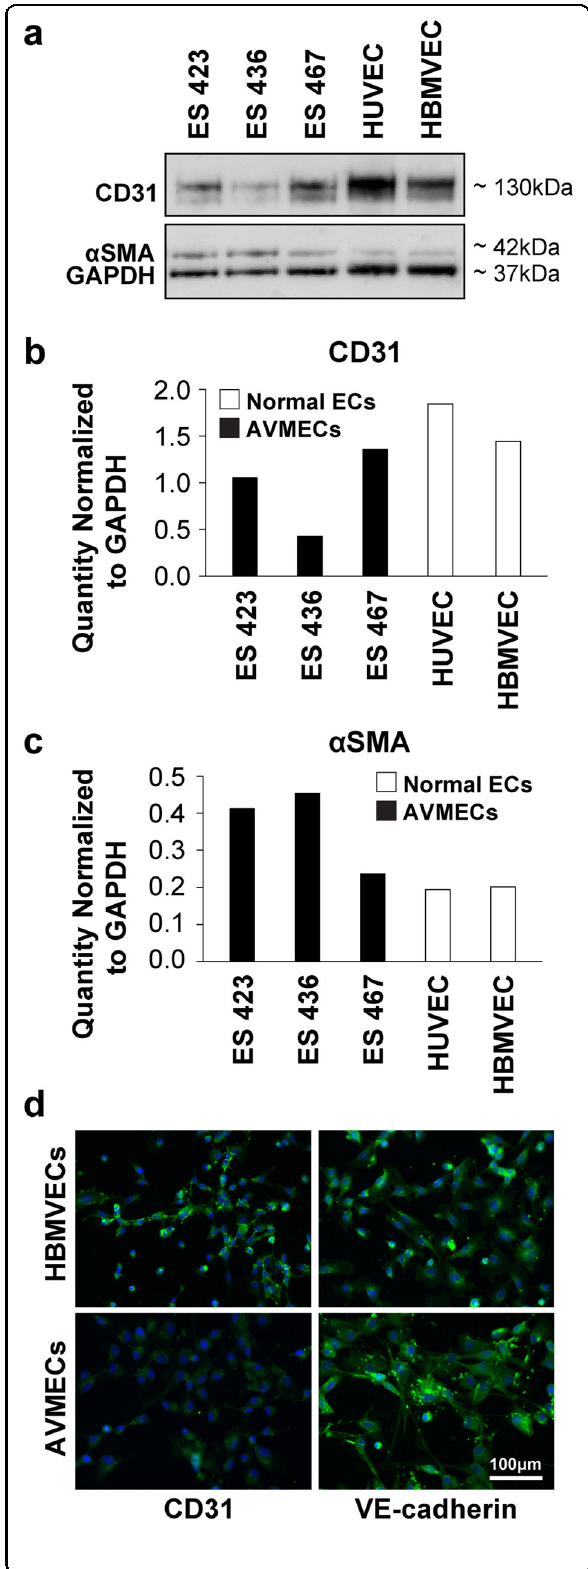
Fig. 1 Characterization of patient-derived AVMECs. Primary endothelial cell lines were isolated from the human AVM tissue of three separate patients. The “ purity ” of primary patient-derived AVMECs was tested by Western blot ( a ) analysis using CD31 as an endothelial marker and α SMA as a mesenchymal marker. AVMECs express levels of CD31 ( b ) and α SMA ( c ) that are comparable with those of commercially available normal vascular endothelial cell lines. AVMEC endothelial identity was further con fi rmed by immuno fl uorescence that identi fi ed positive expression of endothelial lineage markers (CD31 and VE-cadherin). CD31 was also analyzed by Western blot and immuno fl uorescence, and VE-cadherin was analyzed by immuno fl uorescence ( d ) (CD31 and VE-cadherin = green, DAPI (nucleus) = blue). Original magni fi cation ×200. Interestingly, VE- cadherin expression in AVMECs is not observed at the junctions, which is a pattern often noted in endothelial to mesenchymal